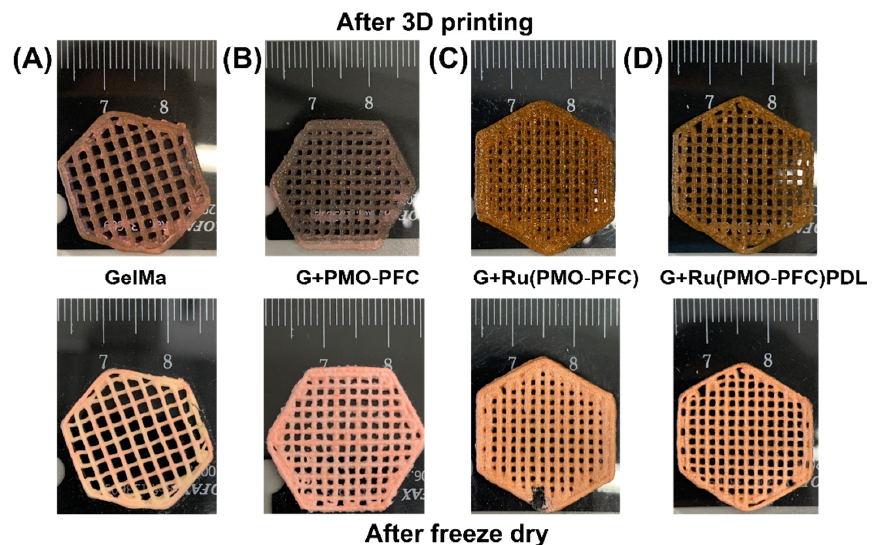
Figure 3. Photograph of 3D printed scaffolds of GelMa ( A ), G+PMO-PFC ( B ), G+Ru(PMO-PFC) ( C ) and G+Ru(PMO-PFC)PDL ( D ) (The top images are after printing; bottom images are after crosslinking and freeze-drying process).